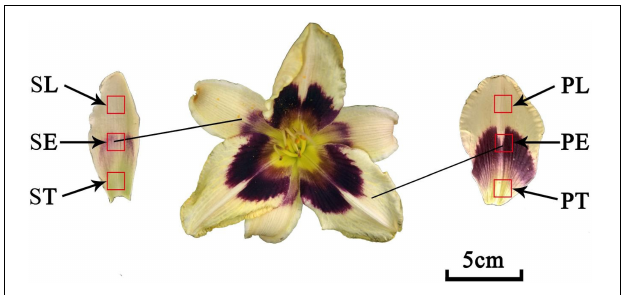
FIGURE 1 | The flower organs of daylily. ST, sepal throat; SE, sepal eye; SL, sepal limb; PT, petal throat; PE, petal eye; PL, petal limb.